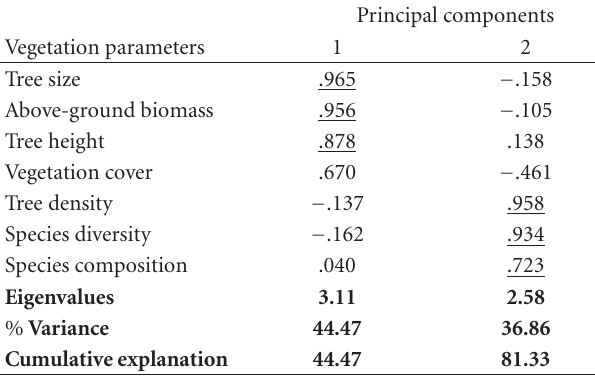
Table 2: Rotated components matrix of vegetation parameters a